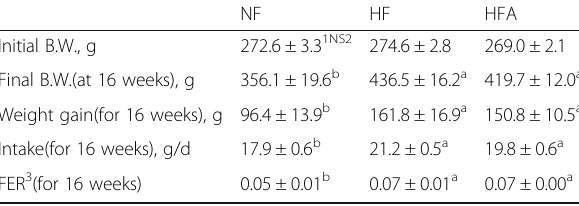
Table 1 Body weight, weight gain, intake and FER of